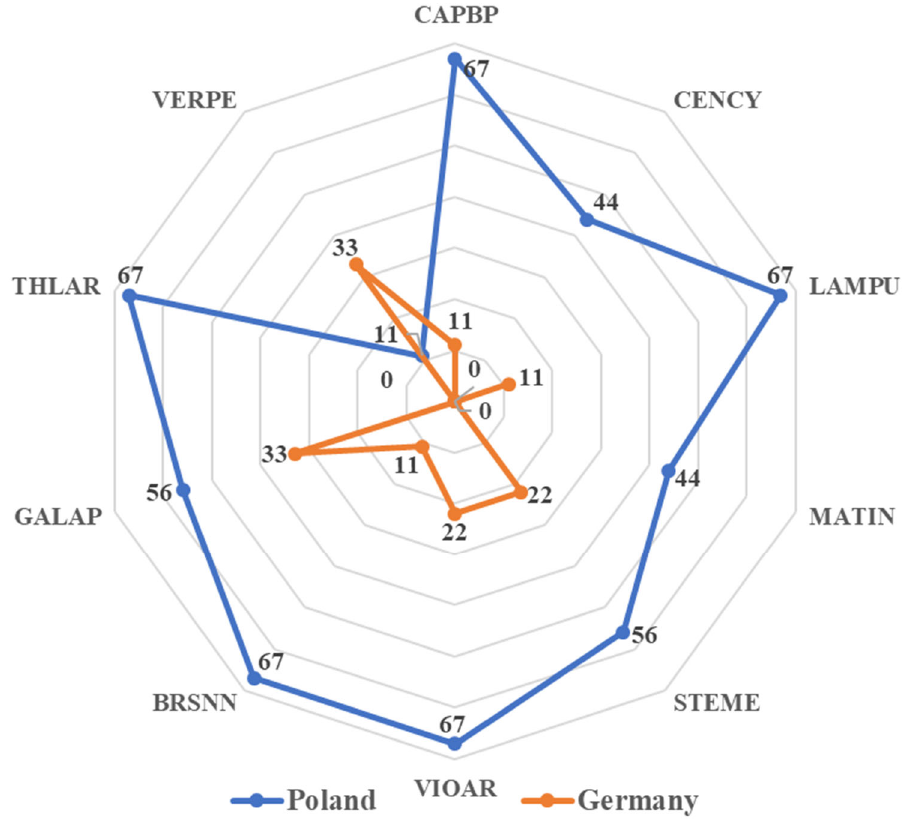
Figure 2. Frequency (%) of weed species in winter cereals in Poland (wheat, triticale, barley)and Germany (wheat, triticale, barley, rye). CAPBP : Capsella bursa ‐ pastoris ; CENCY : Centaurea cyanus ; LAMPU : Lamium purpureum ; MATIN: Tripleurospermum inodorum ; STEME : Stellaria media ; VIOAR : Viola arvensis ; BRSNN : Brassica napus ; GALAP : Galium aparine ; THLAR : Thlaspi arvense ; VERPE : Veronica persica.